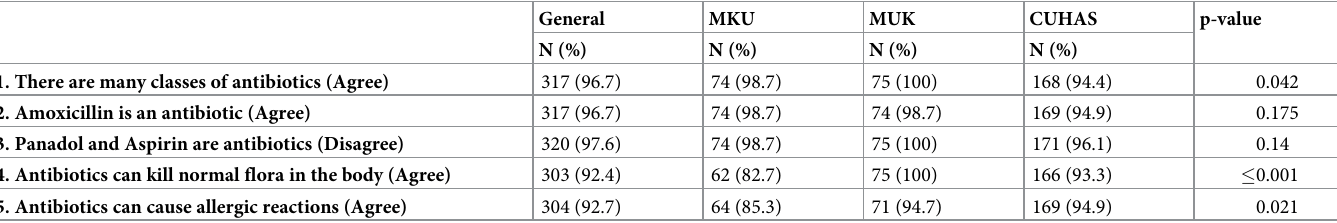
Table 2. General knowledge about